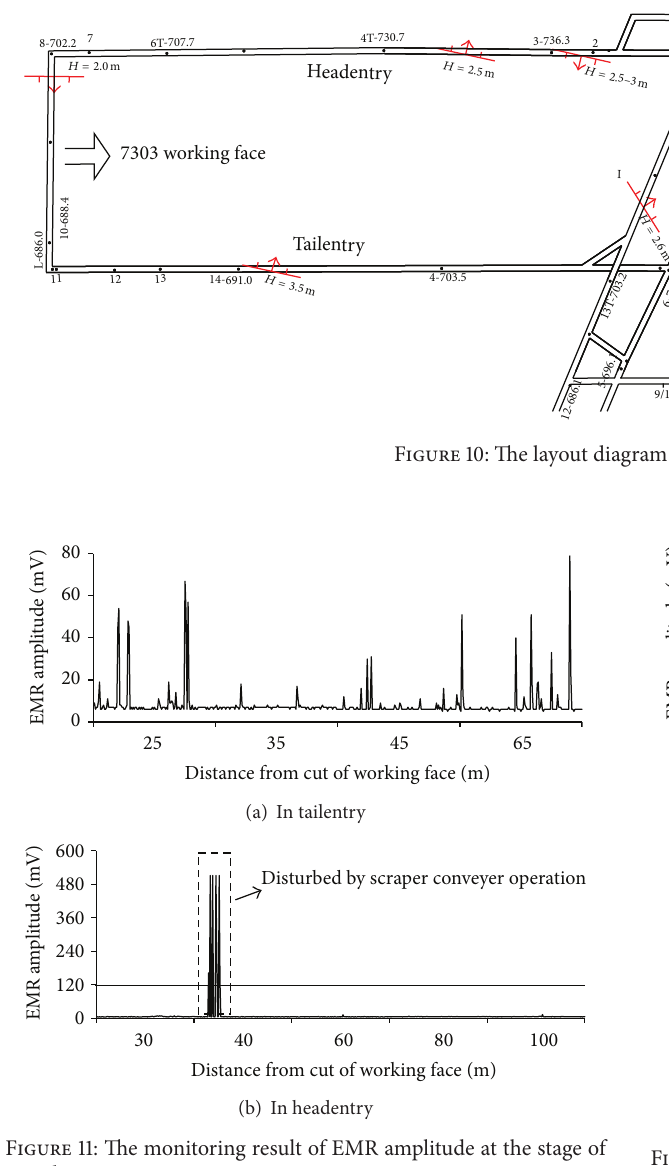
Figure12:ThemonitoringresultofEMRamplitudeatmorningshift on Aug 21.